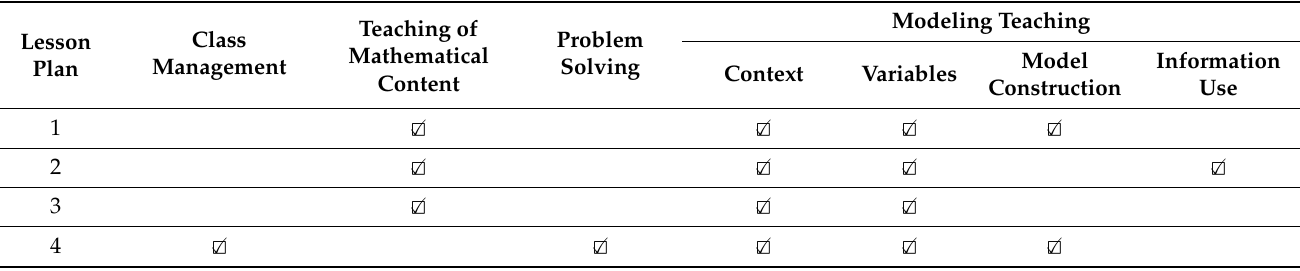
Table 4. Knowledge in the lesson